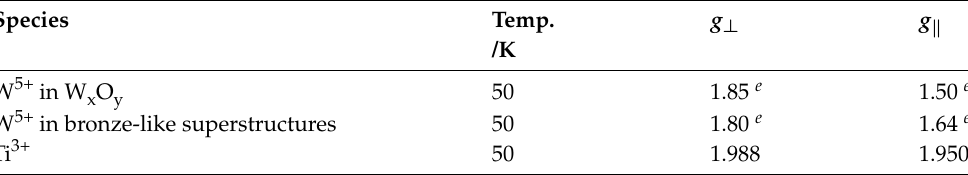
Table 2. Spin Hamiltonian parameters of the paramagnetic metal ion centres. Species Temp. g ⊥ g (cid:107) /K W 5+ in W x O y 50 1.85 e 1.50 e W 5+ in bronze-like superstructures 50 1.80 e 1.64 e Ti 3+ 50 1.988 1.950 5+ in W e ± 0.01. Simulated spectral linewidths were computed using g strain for g ⊥ and g (cid:107) , respectively, W x O y